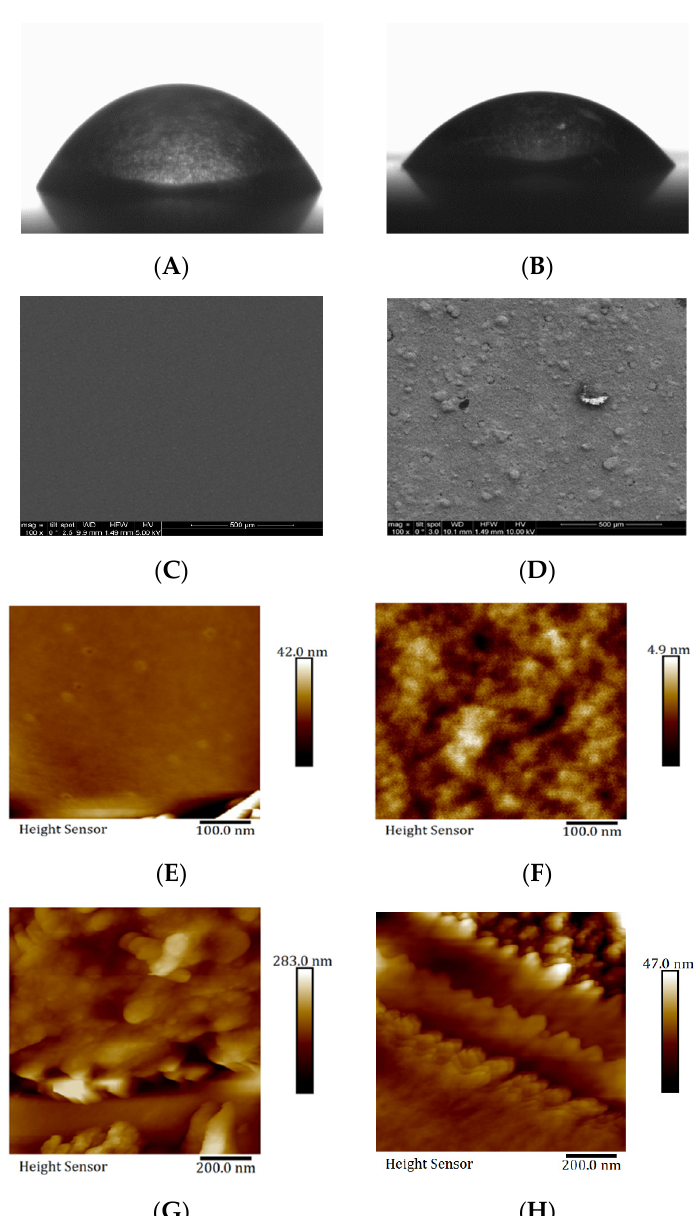
Figure 4. Typical topography of the bare electrode surfaces of gold SPE and modified with SAM. Contact angle graphs of bare electrode ( A ) and SAM-modified electrode ( B ); SEM micrographs of bare electrode ( C ) and 11MUA-SAM-modified electrode ( D ); top cross-section ( × 100 magnification); AFM micrographs ( E ) bare Au, ( F ) 11-MUA SAM (20 h), ( G ) EDC/NHS (1 h), ( H ) BSA-Aroclor 1254 coating